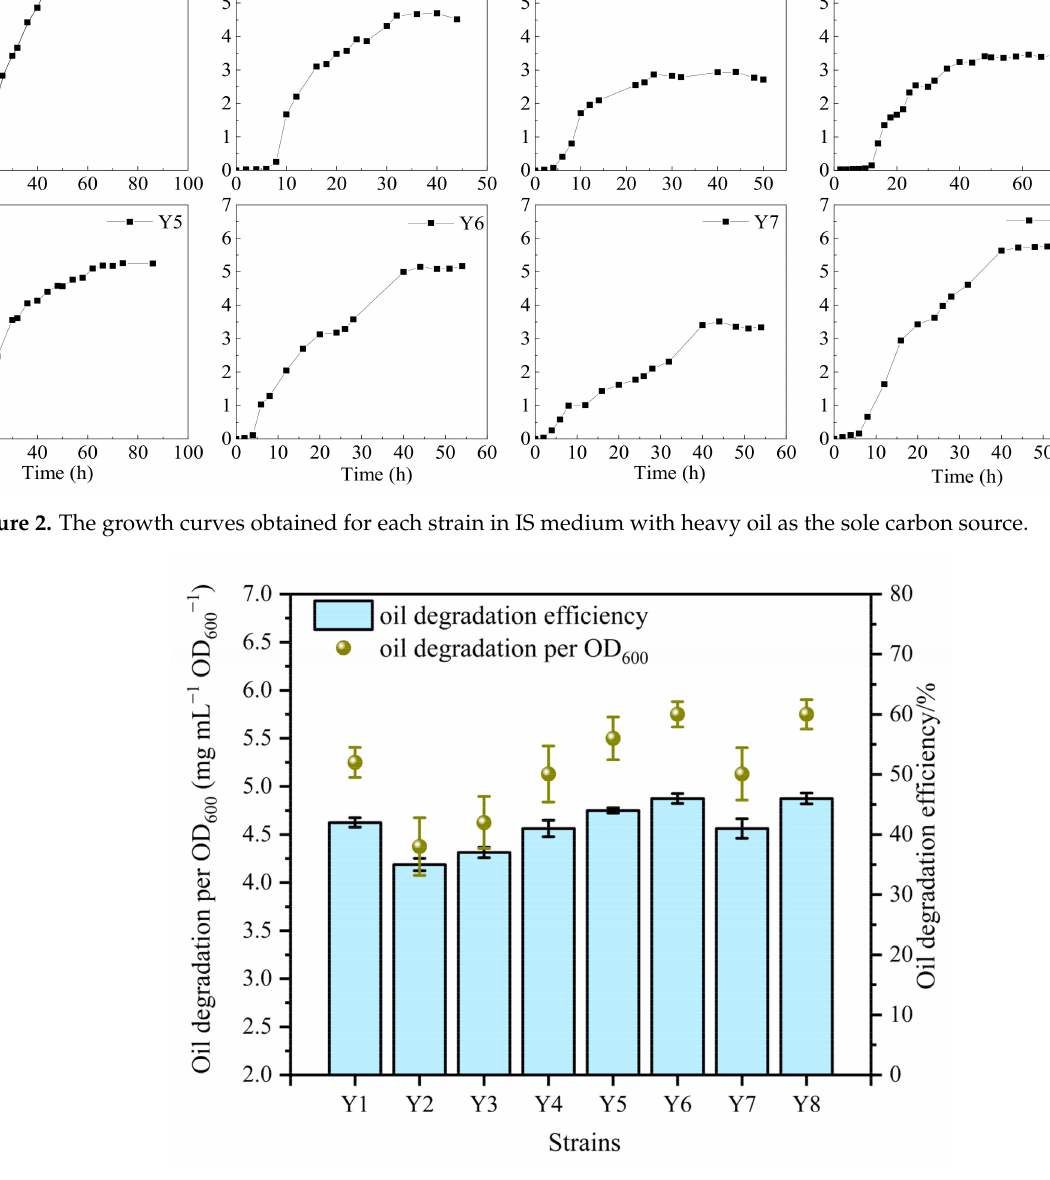
Figure 3. Degradation efficiencies efficiency (%) and amount (mg/mL OD 600 ) of the strains